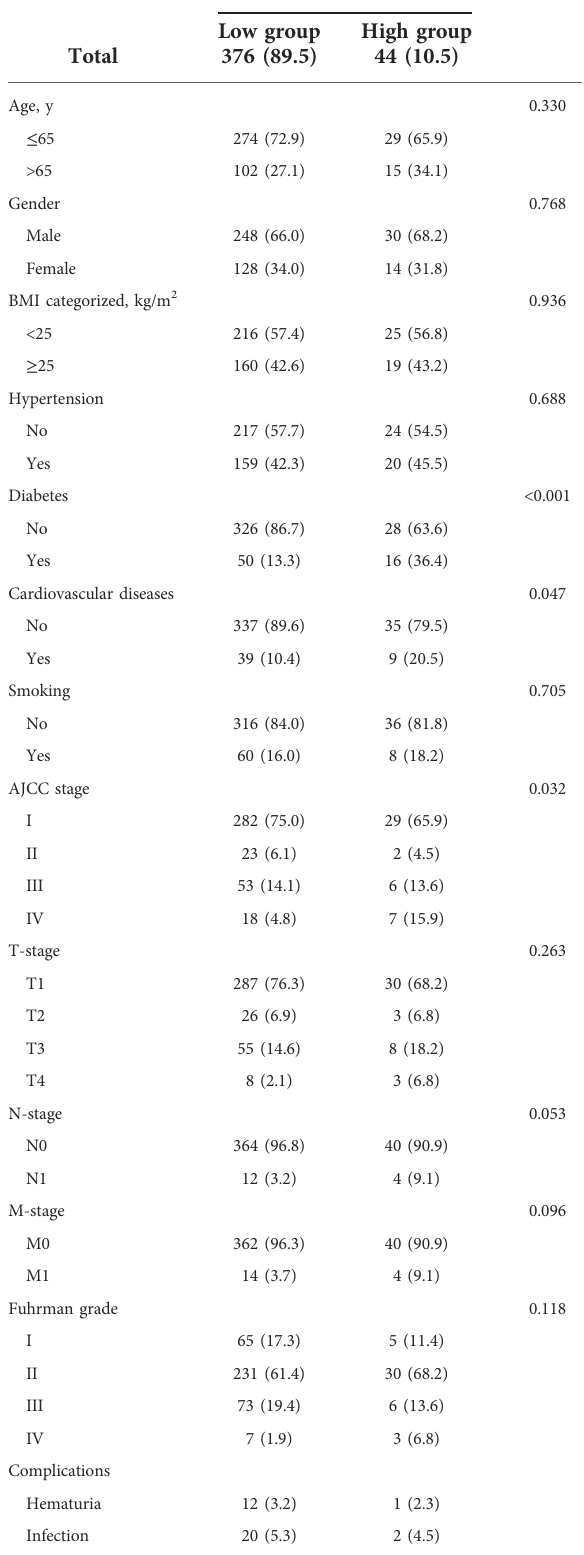
TABLE 1 Baseline characteristics of the patients according to